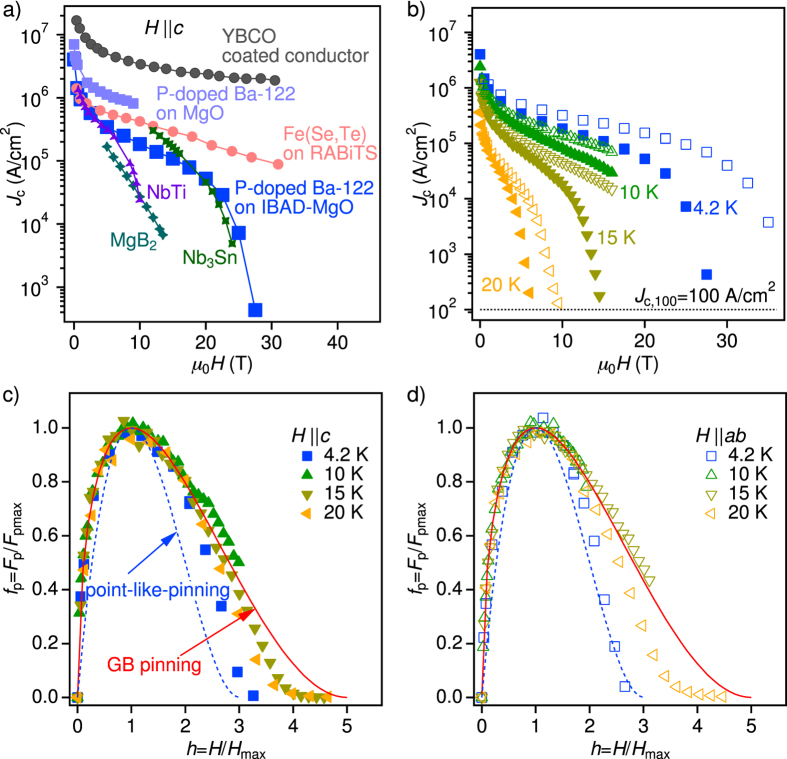
Field dependence of Jc and analysis of the flux pinning density.(a) Jc − H properties of the P-doped Ba-122 coated conductor sample at 4.2 K for H||c in comparison to the data for P-doped Ba-122 on MgO single crystalline substrate15, Fe(Se, Te) on RABiTS21, YBCO coated conductor40, MgB241, NbTi4243, and Nb3Sn4445. (b) Jc − H properties of the P-doped Ba-122 coated conductor sample at various temperatures for both H||c (closed symbols) and H||ab (open symbols). Jc,100 is the criterion (100 A/cm2) used for determining Hirr. (c and d) The normalised pinning force fp as a function of reduced field h. The solid line is  for GB pinning, and the blue dotted line represent point-like pinning, .